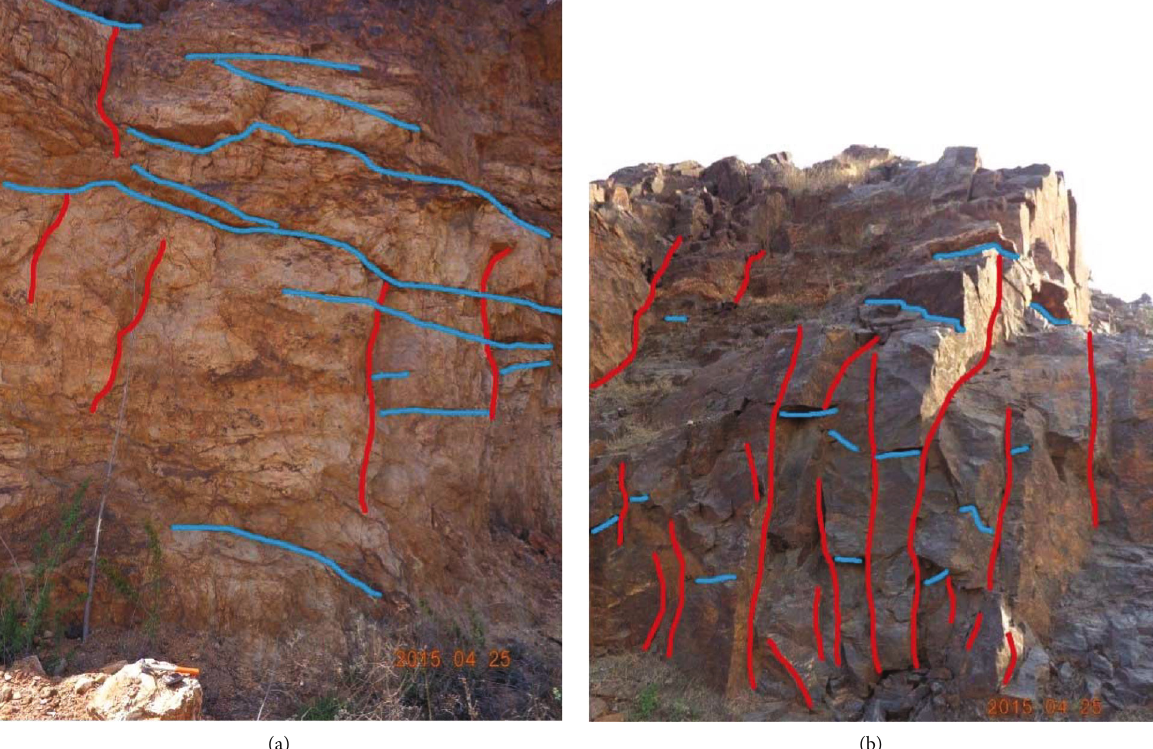
Figure 3: Tedious and tiring manual detection of discontinuities in site investigation. (a) and (b) are examples of manual labelling of discontinuity traces.